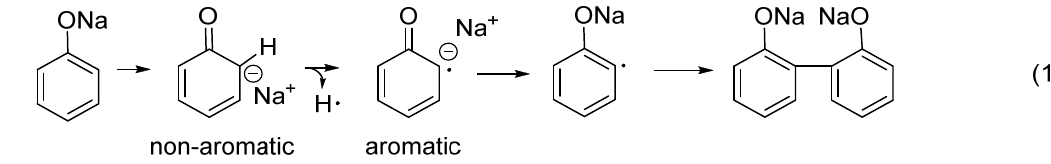
Figure 3. 1 H NMR spectra of sodium phenolates with time at 495 ◦ C. ( a ): whole spectra; ( b ): aromatic protons at 6.0–7.5 ppm; ( c ): PA, PAH, and aldehyde protons at 7.5–10.0 ppm; and ( d ): ratios of PA and PAH protons to all protons.